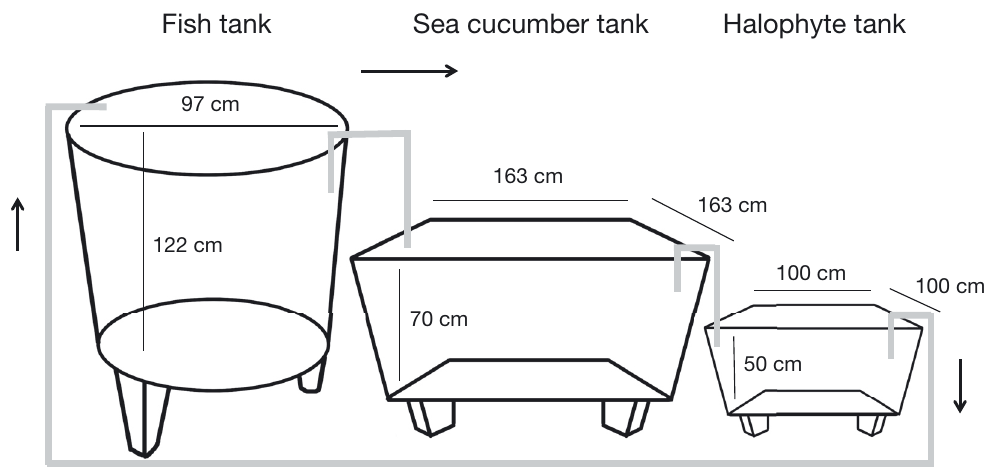
Fig. 1. Schematic set-up of the experimental recirculation aquaculture system (RAS). Grey lines: water pipes; black arrows: direction of water